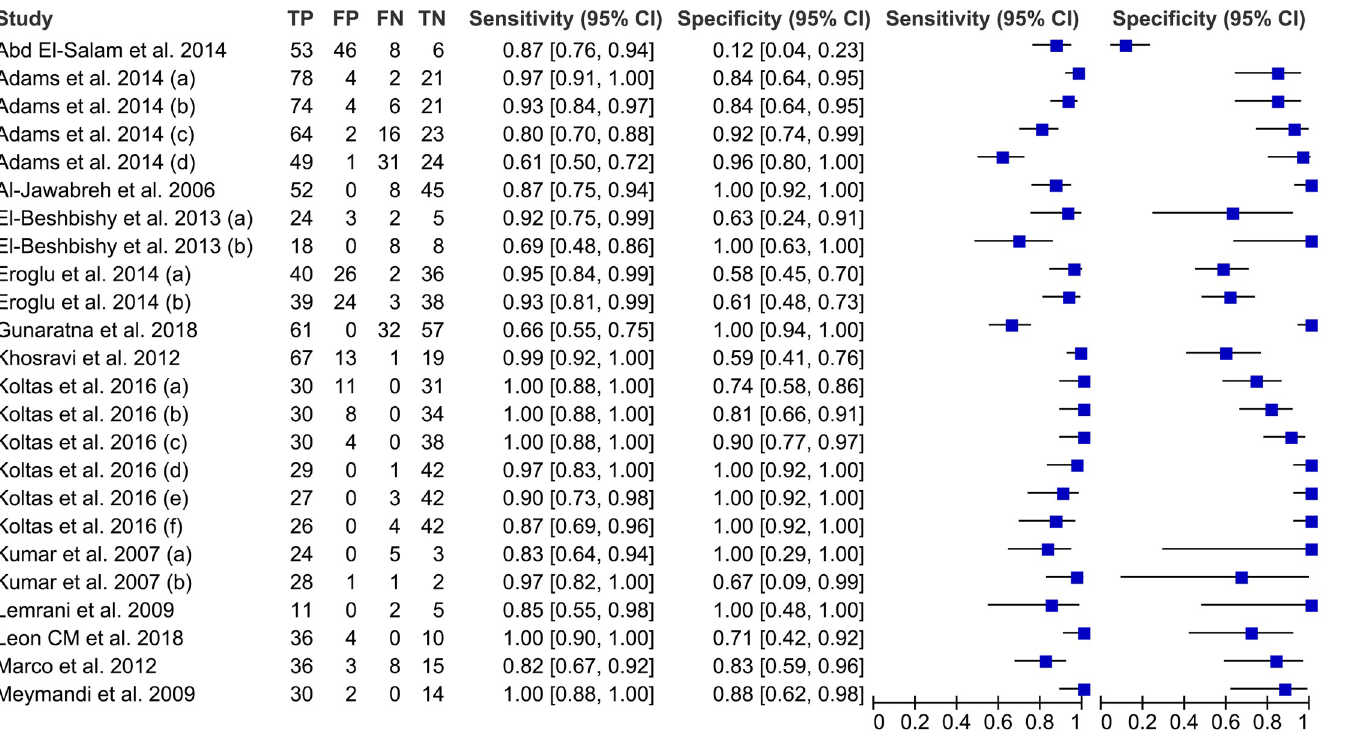
Fig 3. Couplet forest plots of the studies selected in Review Manager 5.3.